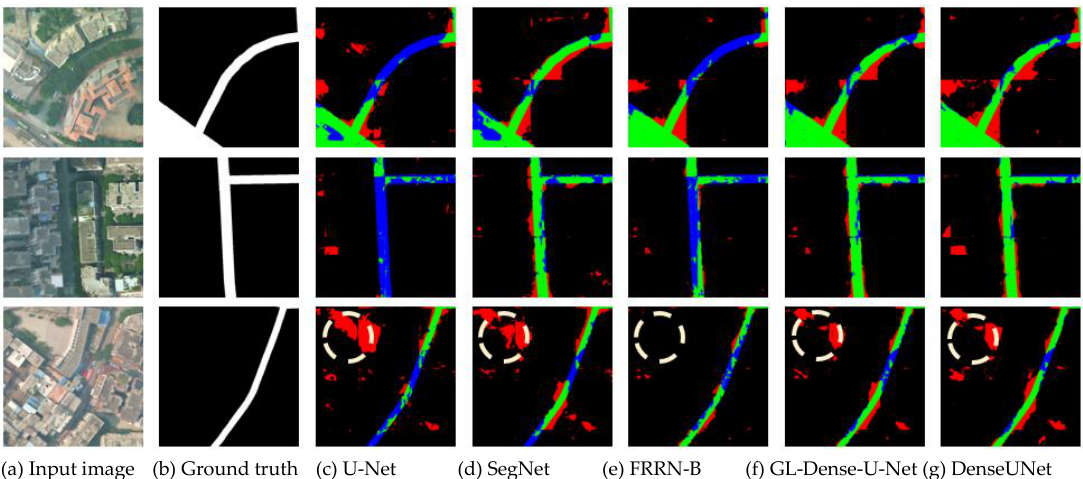
Figure 8. A close-up view of the original true-color composite image and classification results is displayed across three regions using the deep learning method. The images are the subset from the white dotted line marked in Figure 7. True positive (TP), false negative (FN) and false positive (FP) were marked as green, blue, and red, respectively.